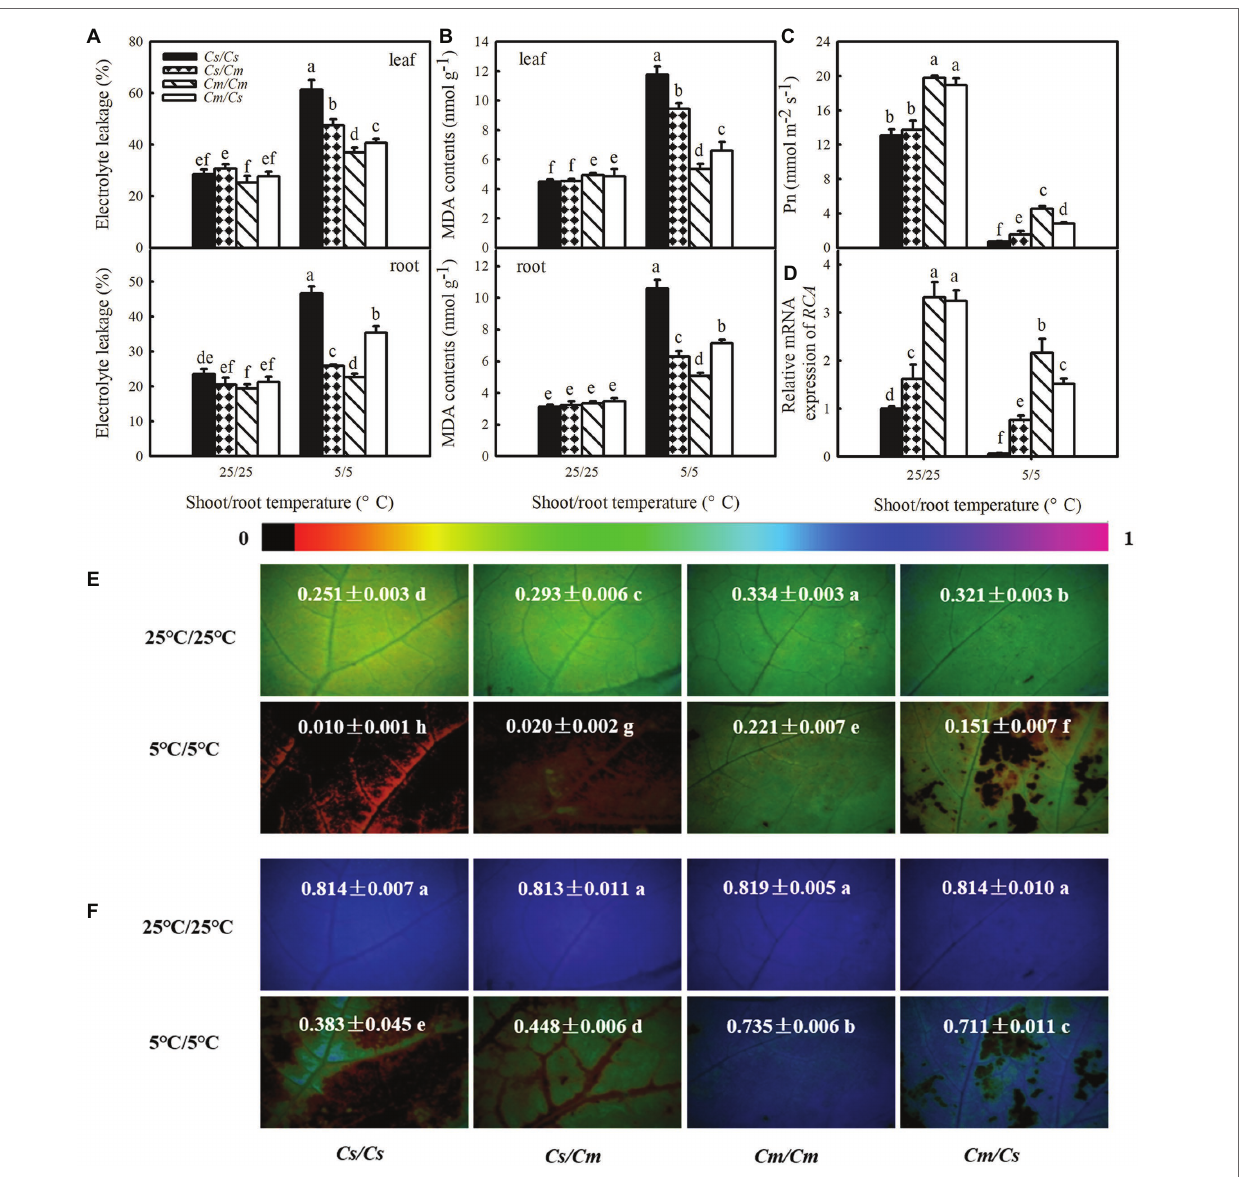
FIGURE 1 | Effect of rootstock on the tolerance to chilling stress of own-root and hetero-root grafted cucumbers and pumpkins. (A) Electrolyte leakage (EL) of leaf and root; (B) malondialdehyde (MDA) content; (C) photosynthetic rate (Pn); (D) , relative expression of Rubisco activase ( RCA ); (E,F) images of actual photochemical efficiency ( Φ PSII ) and maximum photochemical efficiency ( F v / F m ) , respectively, after exposure to 5 ° C for 48 h. The false color code depicted at the top of the image ranging from 0 (black) to 1.0 (purple) represents the degree of photoinhibition at PSII. Data are the means of four replicates (±SDs). Different letters indicate a significant difference between samples according to Duncan’s new multiple range test ( p <